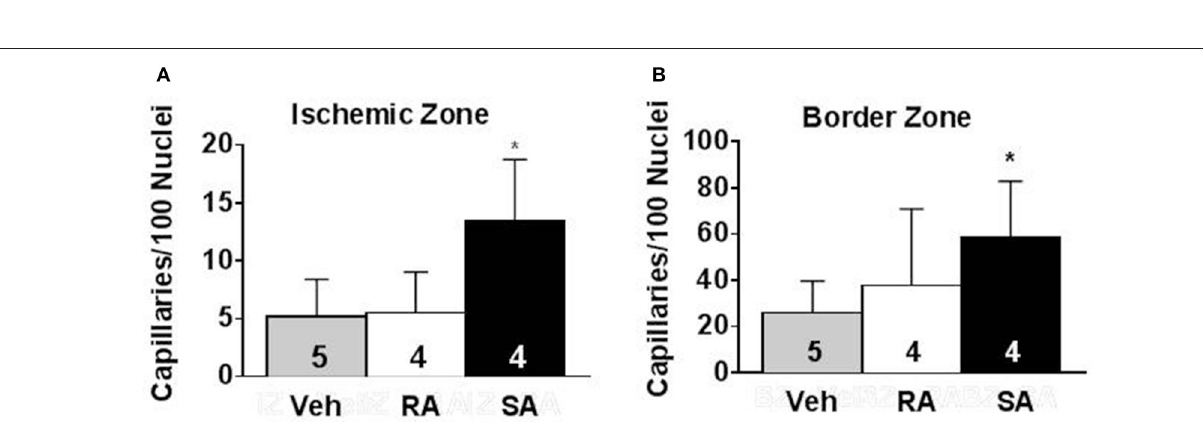
FIGURE 6 | Pro-angiogenic activity of RA and SA c-kit pos CMCs in vivo. Capillary density in the ischemic zone (A) and border zone (B) of hearts 37 days after MI was evaluated by isolectin B4 staining. Values are mean ± SD. * p < 0.05 vs vehicle